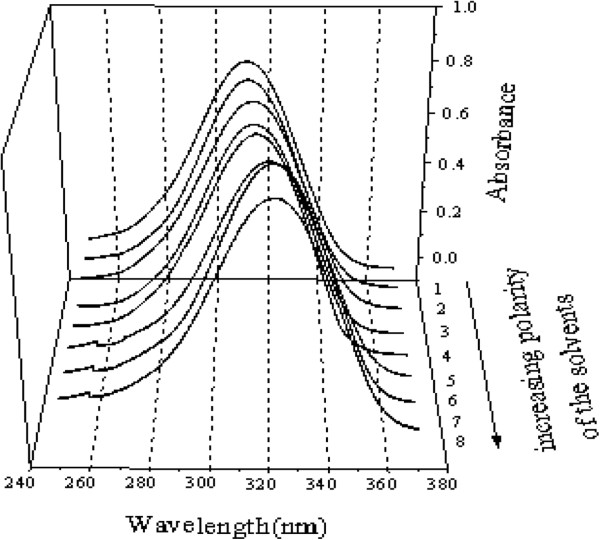
The electronic absorption spectra of a 3.8 × 10-5 mol liter-1 5-Methoxy-5,6-diphenyl-4,5-dihydro-2H-1,2,4-triazine-3-thione in organic solvents:(1)C6H12 (2)CCl4 (3)CHCl3 (4)EtOH (5)MeOH (6)DMF (7)CH3CN (8)DMSO.